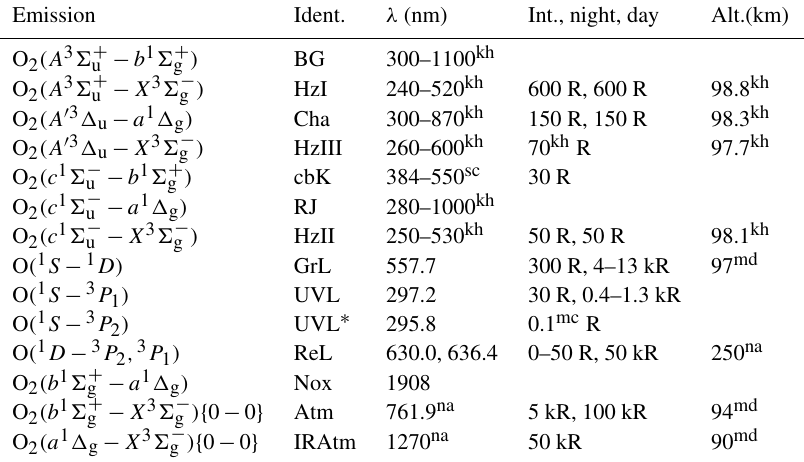
Table 1. Relevant optical transitions of terrestrial airglow in the Earth’s atmosphere. Emissions (see the column labeled “Emission”) observed in the wavelength range shown in the λ column are denoted by abbreviations (see the column labeled “Ident.”). Typical intensity values of an integrated (limb) emission rate profile are given for nightglow (see the “Int.” column before the comma) and, if available, dayglow (see the “Int.”column after the comma). The altitudes of the corresponding emission rate peaks are shown in the column labeled “Alt.”. Atomic oxygen emissions are denoted by abbreviations as follows. GrL – the green line emission at 557.7nm, ReL – the red line emissions at 630.0 and 636.4nm, UVL and UVL ∗ – the ultraviolet line emissions at 297.2 and 295.8nm, respectively. Molecular oxygen emissions are denoted by abbreviations as follows. IRAtm – the infrared atmospheric band emission at 1270nm, Atm – the atmospheric band emission at 761.9nm, Nox – the atmospheric band emission at 1908nm, HzI – the Herzberg I band emissions, BG – the Broida–Gaydon band emissions, Cha – the Chamberlain band emissions, HzIII – the Herzberg III band emissions, HzII – the Herzberg II band emissions, cbK – the new system band emissions measured using the Keck I/II instrument (Slanger et al., 2004a), RJ – the Richards–Johnson band emissions. References are marked with upper indices as follows: sc – Slanger and Copeland (2003), mc – McConkey et al. (1966), na – Nagy et al. (2008), md – McDade (1998), kh – Khomich et al. (2008). Emission